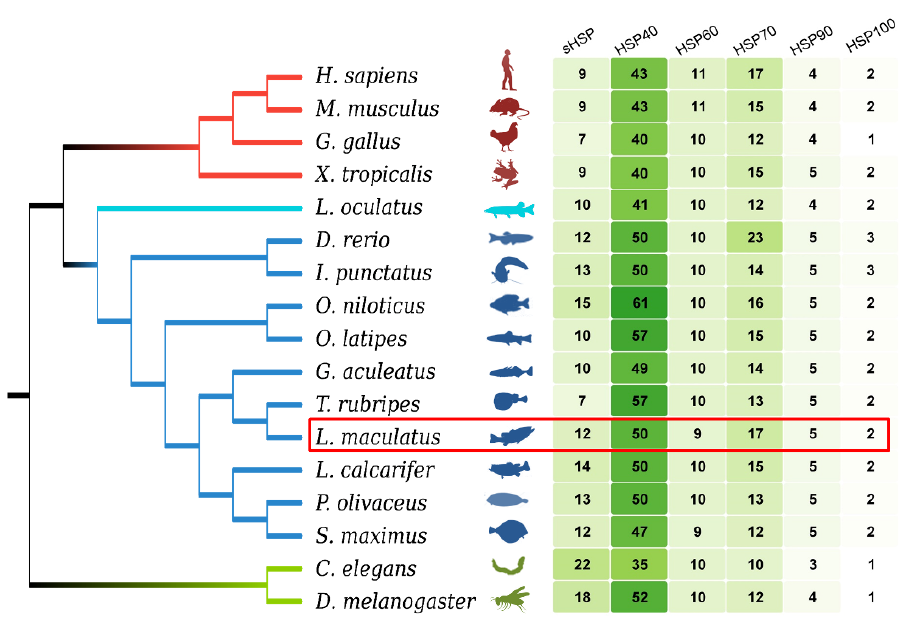
Figure 1. Genome-wide identification of Hsp families in 10 teleost species and other metazoan species, with L. maculatus in the red frame. Branches with different colors represent different metazoan groups. The gene numbers are illustrated with the heatmap.